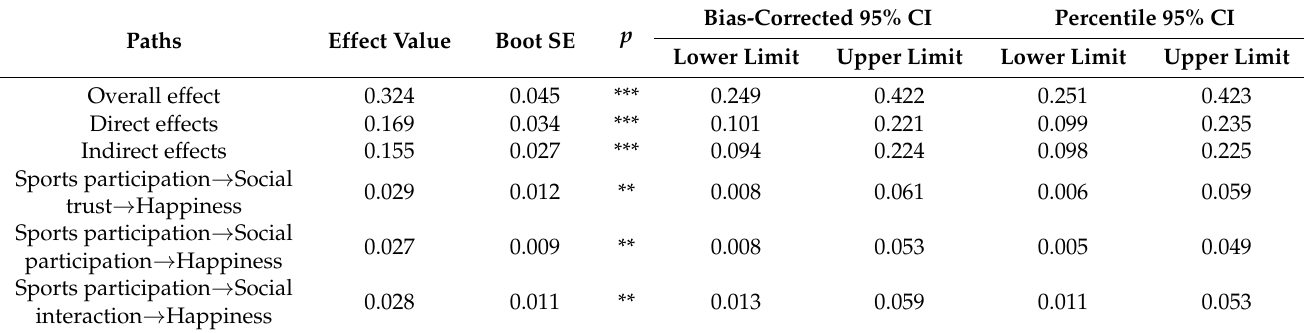
Table 6. Path test results for the mediating function of